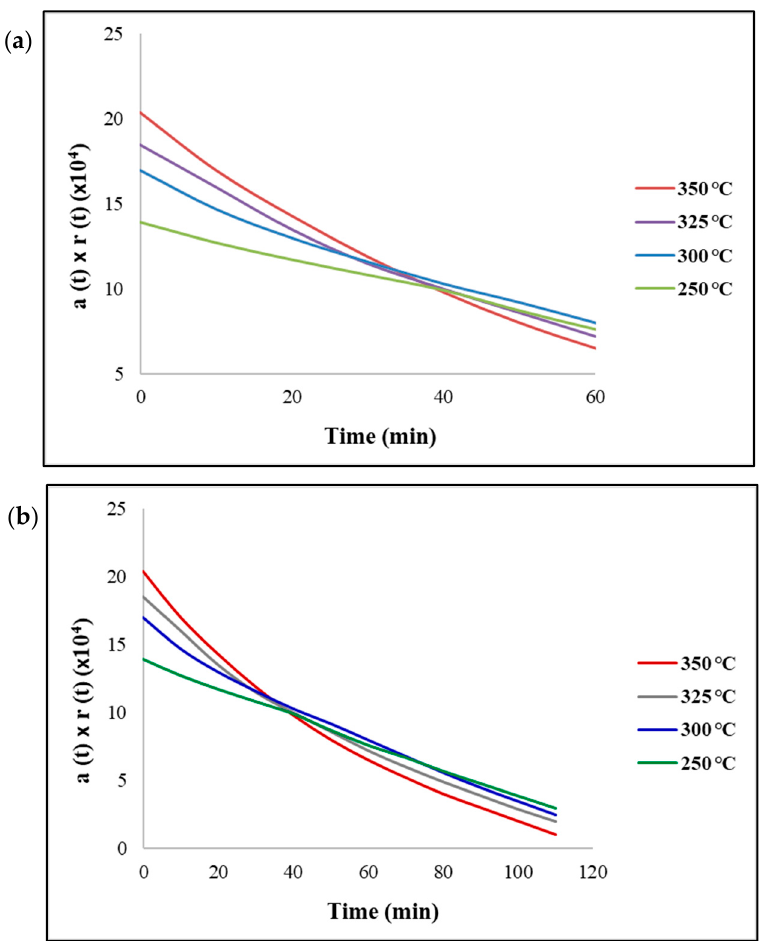
Figure 4. Reaction rate as a function of time with catalyst = Ni/ZrO 2 at ( a ) t = 60 min and ( b ) t = 120 min. Reaction conditions: pressure = 30 bar, H 2 /oil ratio = 1000 and inlet liquid flow = 0.1 mL/min.